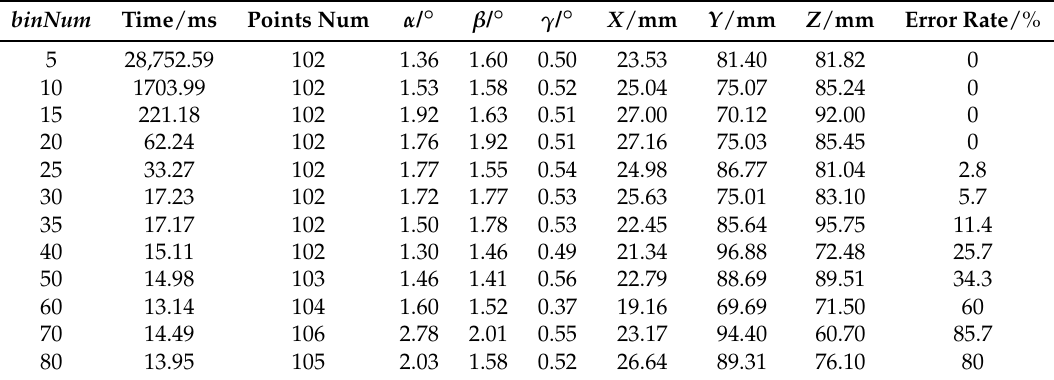
Table 1. The average estimation pose error of different binNum .